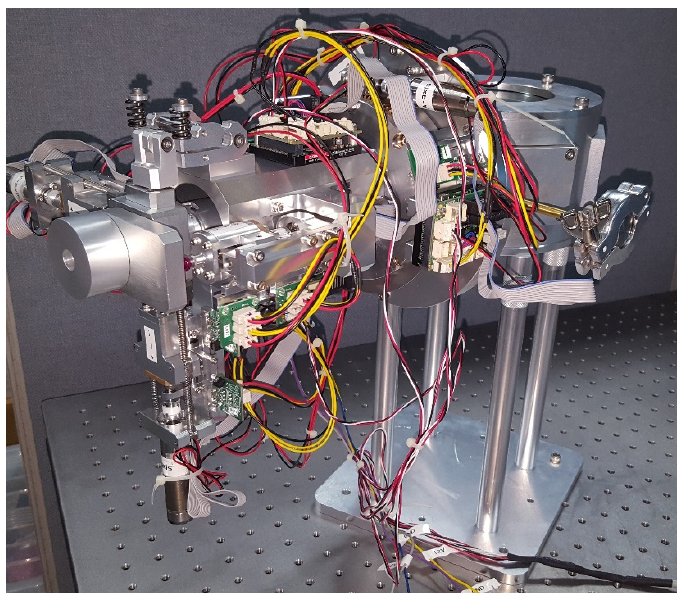
Figure 10. Goniometer-type specimen stage.